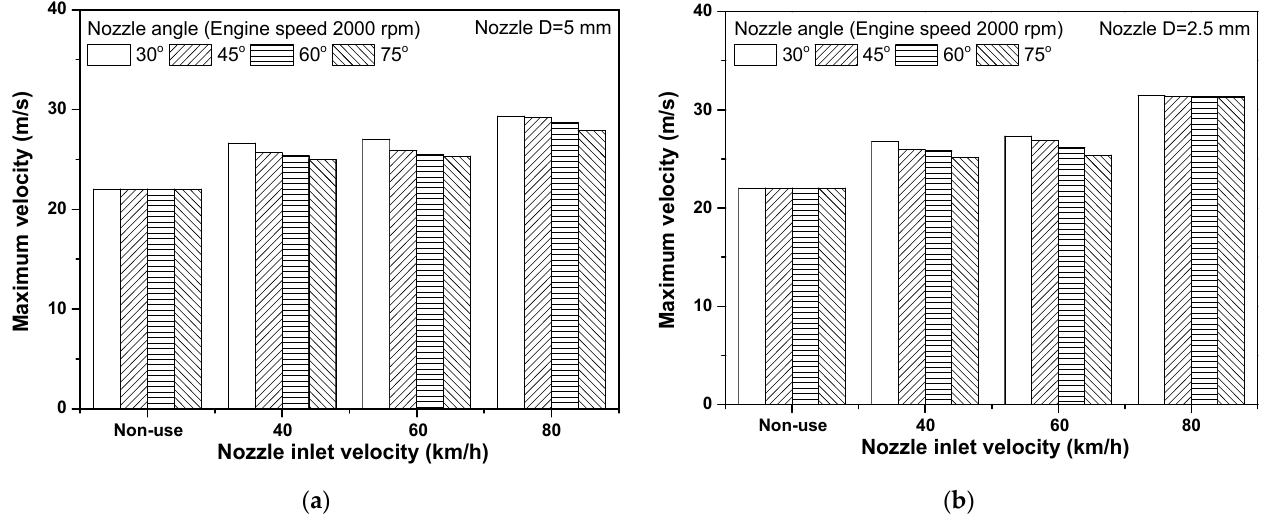
Figure 5 . Maximum velocity in the intake manifold according to nozzle diameter with the nozzle inlet velocity. ( a ) Nozzle diameter; ( b ) nozzle diameter of 2.5 mm.